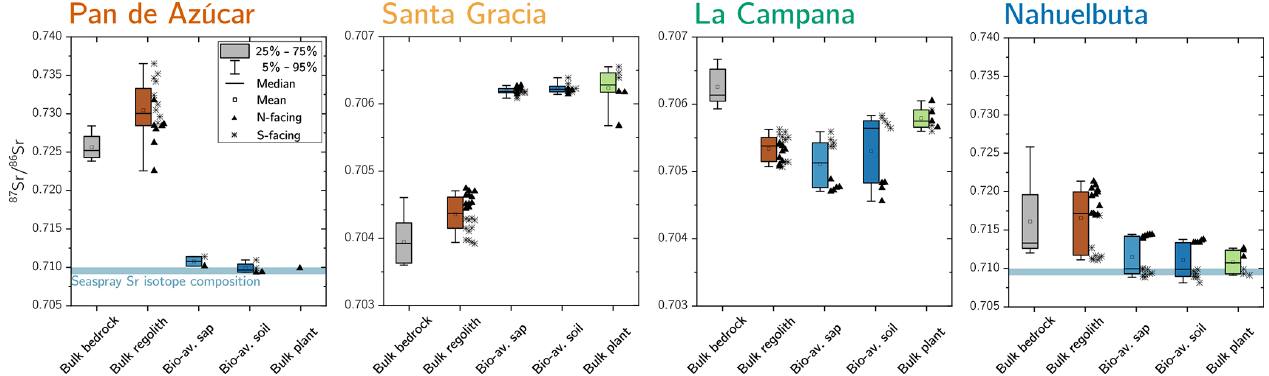
Figure 5. Average 87 Sr / 86 Sr isotope composition of bedrock, bulk regolith, and the bioavailable fraction in saprolite, soil, and plants in Azúcar, Santa Gracia, La Campana, and Nahuelbuta. The 87 Sr / 86 Sr isotope ratios of bulk plant (green) are weighted according to the single species’ organs relative growth rate (see Table 4 for weighting parameters). Whiskers span 90% of the respective dataset. On the boxes’ right-hand side, the differences between north- and south-facing regolith profiles are depicted. Note that bulk regolith samples in Nahuelbuta with anomalously low Zr concentrations have been excluded from this analysis as they are suspected to comprise a different parent rock. The y axis covers a broader range in Pan de Azúcar and Nahuelbuta than in Santa Gracia and La Campana.